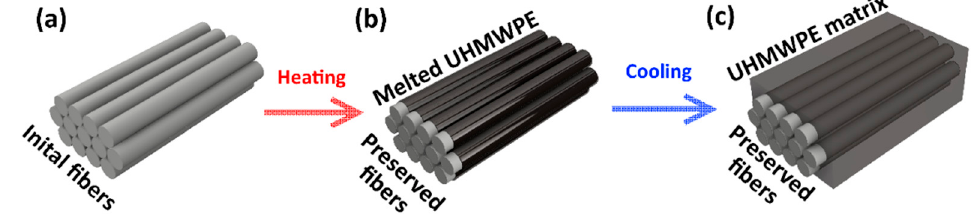
Figure 2. Schematic diagram of the self-reinforced composite (SRC) preparation: ( a ) initial fiber with winding, ( b ) molten fibers during hot compaction, and ( c ) the resulting self-reinforced composite.